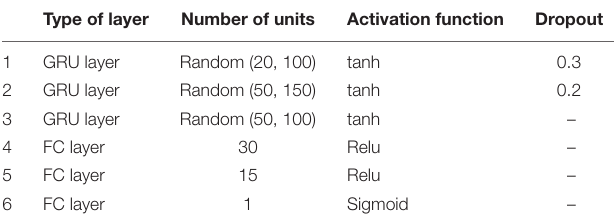
TABLE 2 | Parameter setting of a single GRU based model.